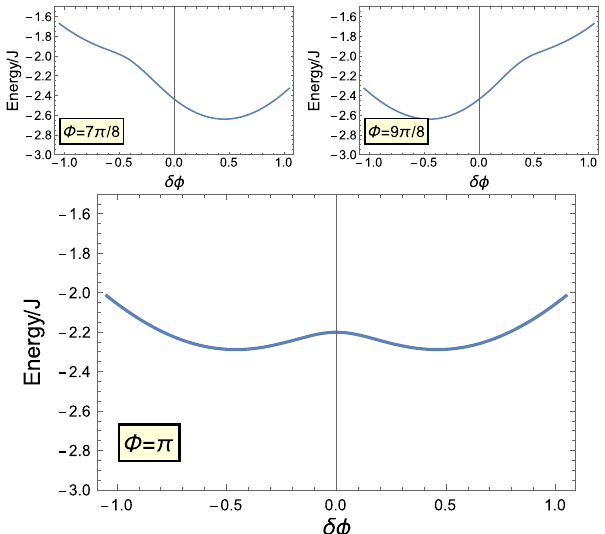
FIG. 5. Potential energy vs the superconducting phase differ- ence δϕ (minimized over the average superconducting phase near the degeneracy point, plotted for a strong junction twice as strong as the average of the other two ( λ ¼ 2 ) and a Josephson asymmetry ϵ ¼ 0 . 1 . Note that two inequivalent minima develop when the flux from the external field Φ ¼ π , and an instanton event is required for the system to remain in the absolute minimum of energy as Φ is tuned past this point. This instanton may occur either with a forward or a backward jump in there is interference between the two